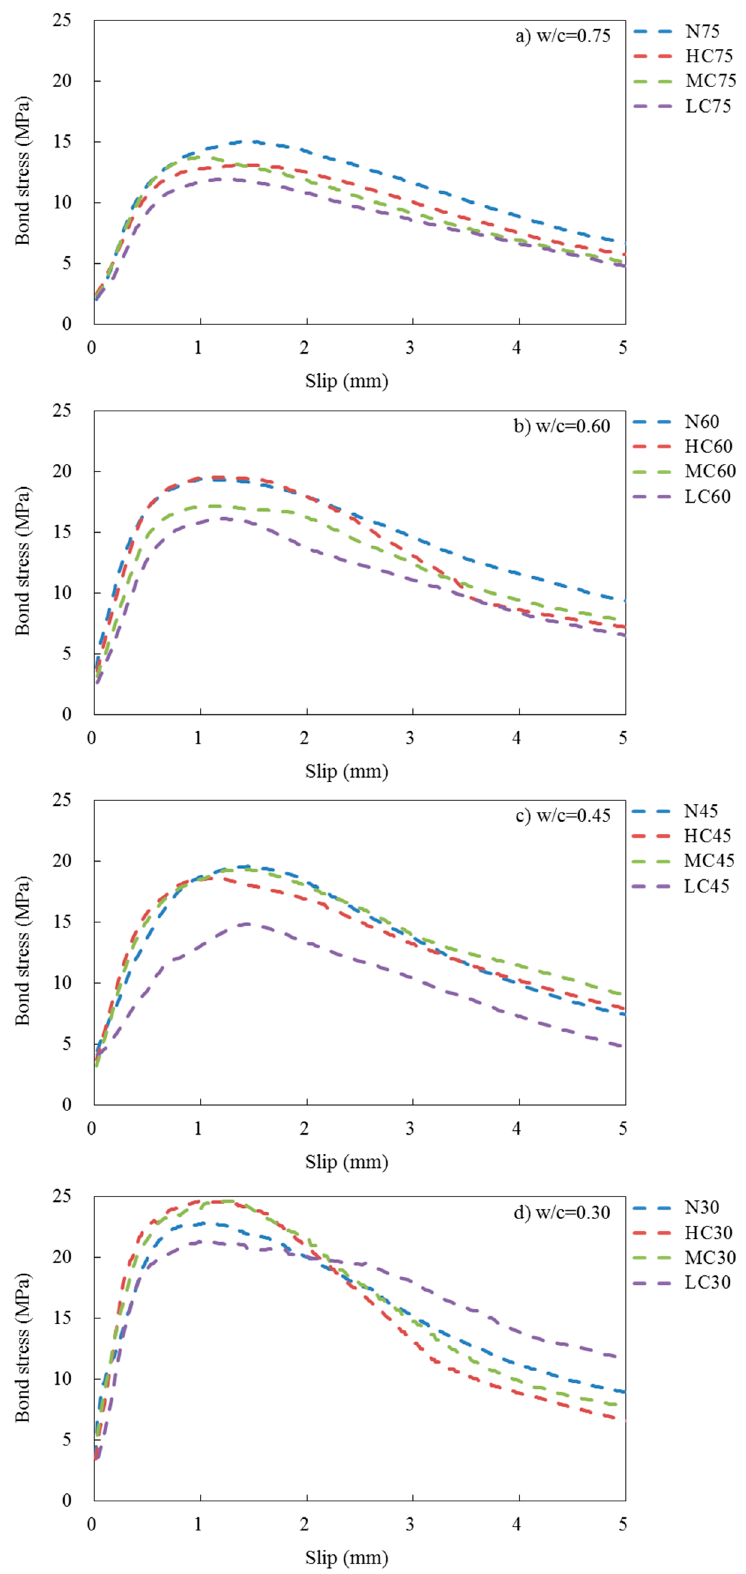
Figure 14. Bond stress-slip relationship of the concrete with a 13-mm-diameter steel rebar with different water-to-cement ratios. ( a ) For w/c = 0.75; ( b ) for w/c = 0.60; ( c ) for w/c = 0.45; ( d ) for w/c = 0.30.